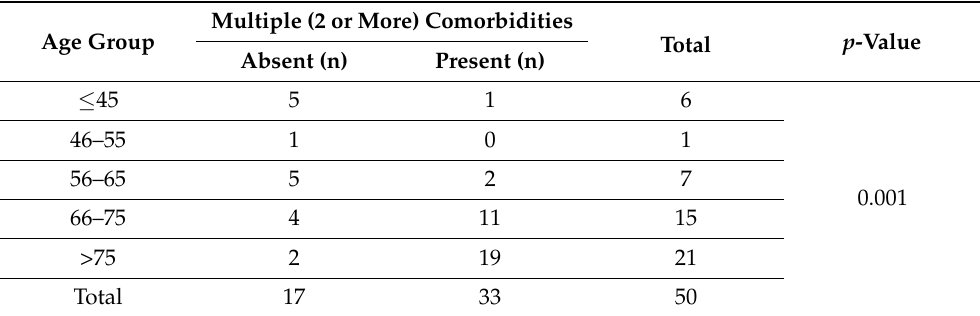
Table 1. Age wise distribution of comorbidities among mortalities in STIDH (n = 50).